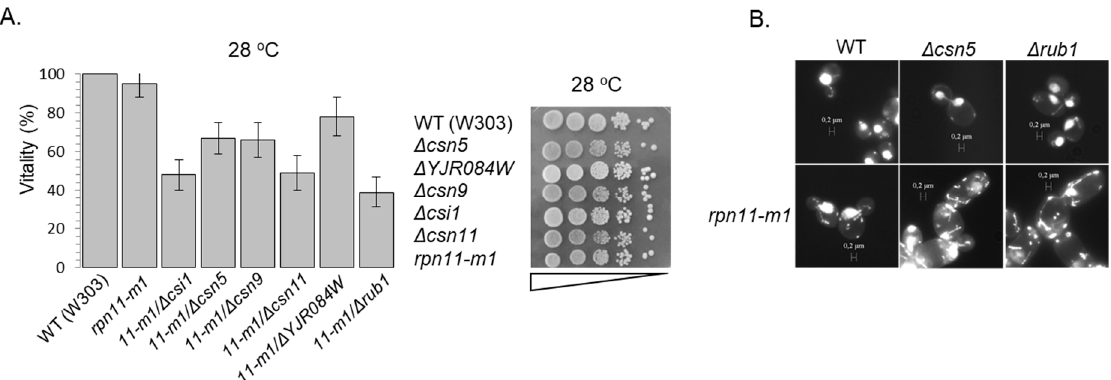
Figure 5. Rpn11 is a component of the SCF axis. ( A ) Vitality of double mutants cells was determined by the loss of their ability to from colonies upon plating on glucose rich agar plates at a permissive temperature. Experiments were done thrice ( n = 3) and statistical significance was confirmed (left). Vitality of single mutants was determined through a drop assay by plating cultures in serial dilution in YPD agar dishes (right). Supplementary Figure 5 (S5) includes complementary data. ( B ) Tetrads of WT, single or double mutant strains, or mutant yeast strains separated into spores and the annotated strains grown to the first logarithmic phase in the permissive temperature of 28 °C. Cells were stained for nucleic acids by DAPI (4 ′ ,6-diamidino-2-phenylindole) and observed by × 63 oil immersion objective using a florescence microscope. In the double mutants, an aberrant cell phenotype reminiscent of the semi-lethal phenotype can be observed.